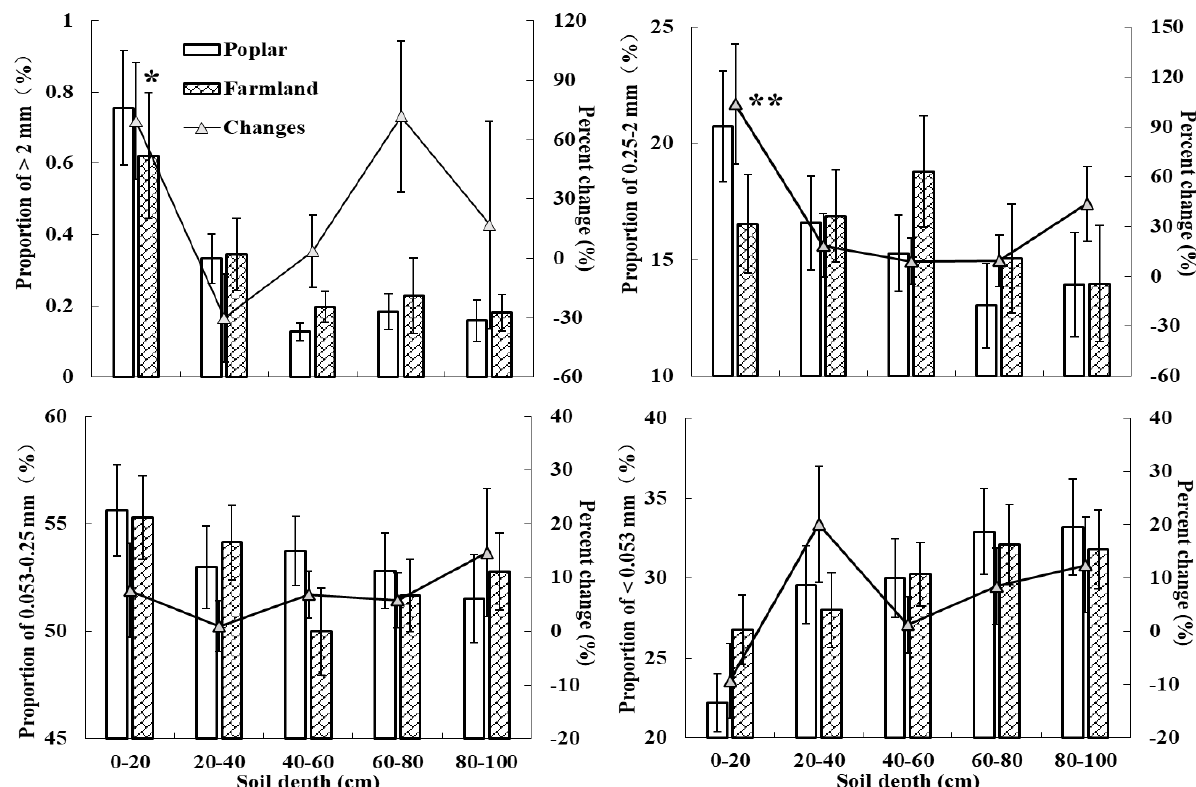
Figure 2. The effects of shelterbelt on soil aggregates distribution in 0–20 cm, 20–40 cm, 40–60 cm, 60–80 cm, and 80–100 cm. Broken lines are percent changes of shelterbelt − induced soil aggregate proportions, ** indicates significant differences at p < 0.001, and * indicates the significant differences at p < 0.05 between the changes in shelterbelt − induced and farmlands in same soil layer. Error bars are the standard errors.